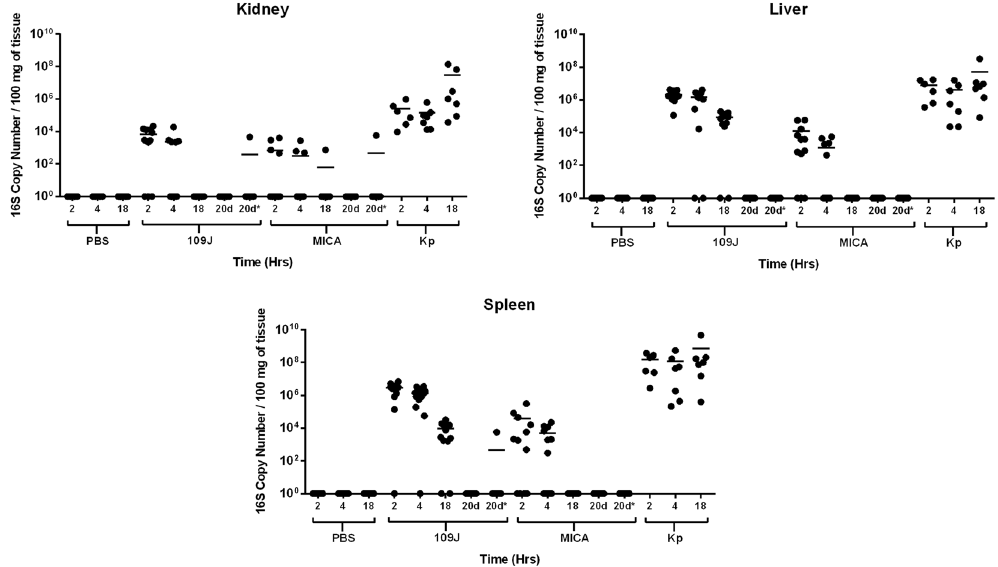
Figure 4. Predatory bacterial dissemination within host. qPCR detection of predatory bacteria within the host was performed. The kidneys, livers, and spleens were probed for B. bacteriovorus 109J, or M. aeruginosavorus (MICA), and K. pneumoniae at two, four, and 18 hours post-injection. Twelve rats per treatment group (seven for K. pneumoniae ) were analyzed at each time point. Each data point represents a single rat’s respective bacterial load. Horizontal lines represent the mean of the results from each treatment set. Data are combined from the results of two independent